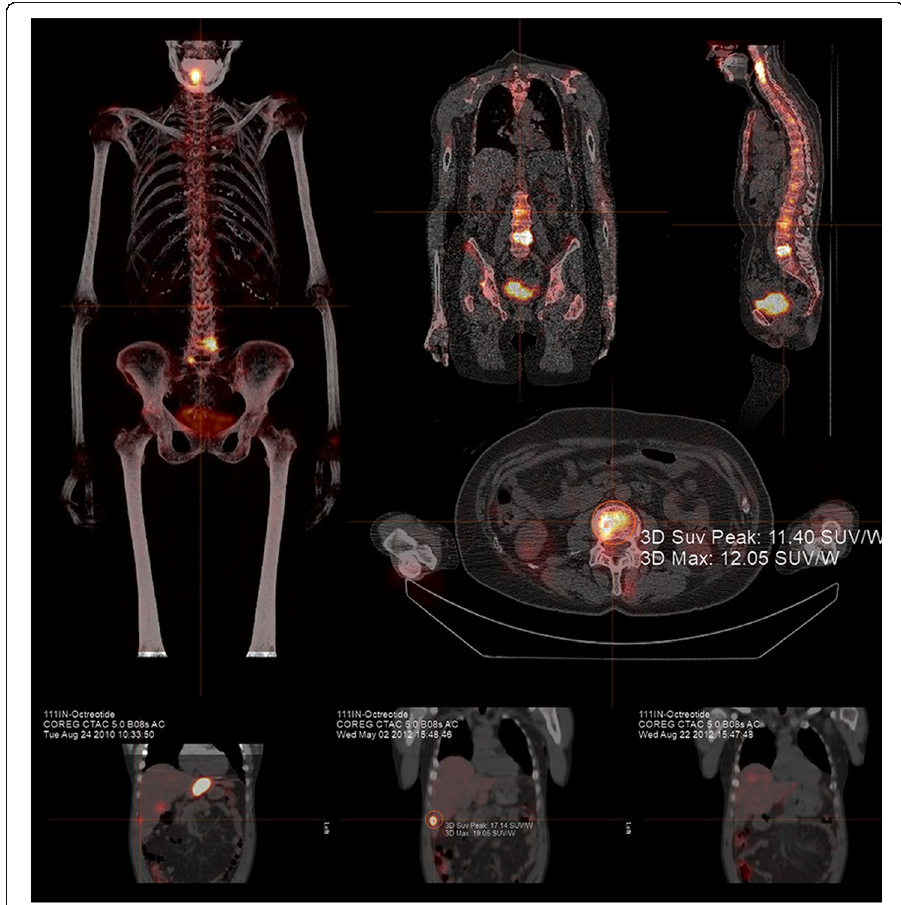
Fig. 7 Absolute quantification is possible with Hybrid Recon ™ (Hermes Medical Solutions). An SUV max of 12.05 and an SUV peak of 11.40 were generated in the delineated area of this patient ’ s lumbar spine. (Images courtesy of Hermes Medical Solutions, London,